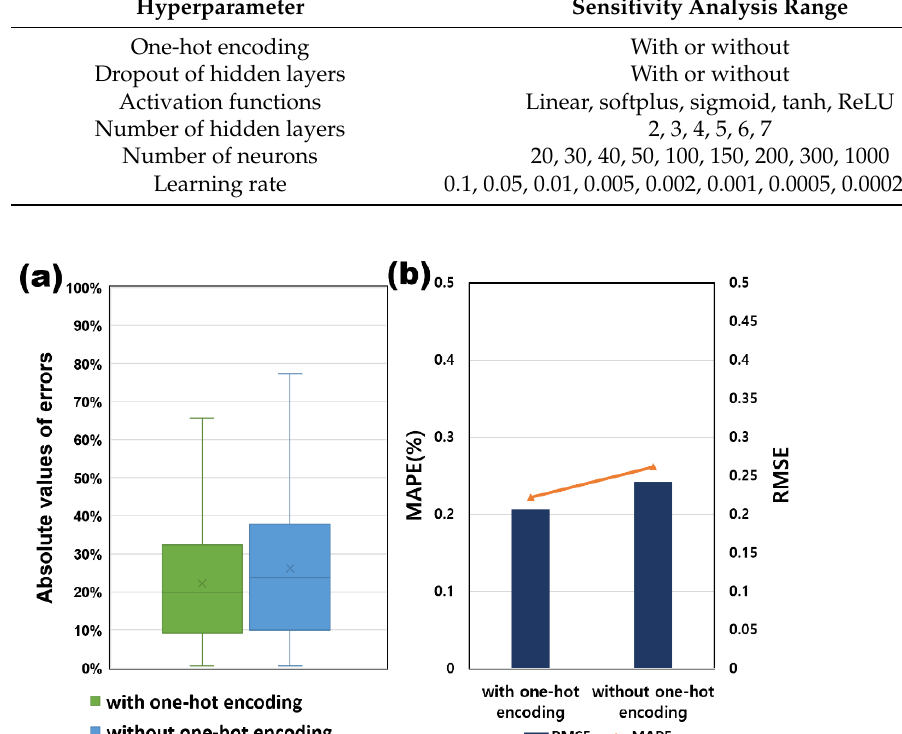
Figure 13. One-hot encoding sensitivity analysis results of DNN models. ( a ) absolute error; ( b ) RMSE and MAPE.